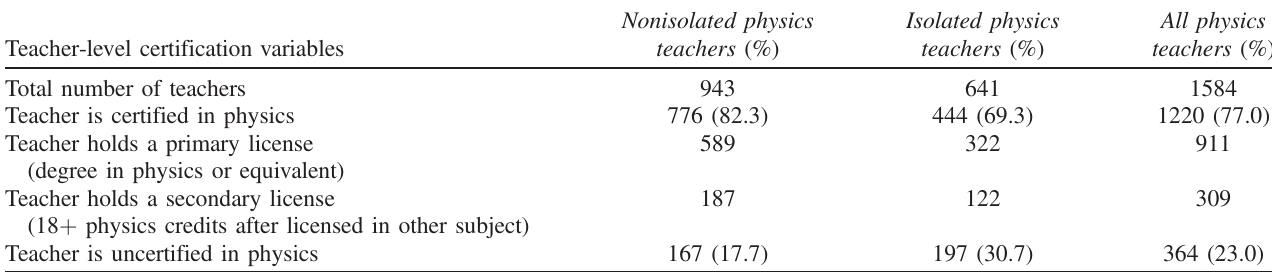
TABLE II. Certifications of isolated and nonisolated physics